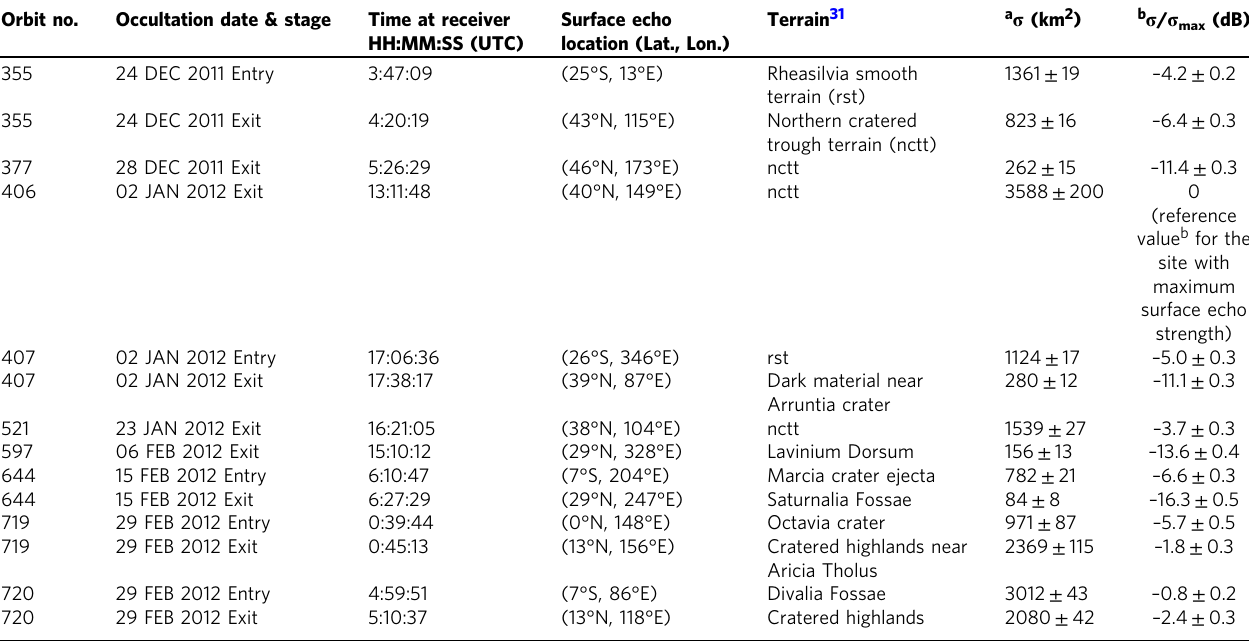
Table 1 Forward-scatter radar cross sections σ of Vesta ’ s surface measured at each echo site from high-incidence BSR surface re fl ections Orbit